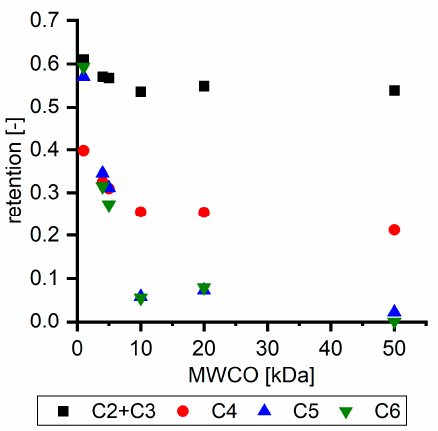
Figure 3. Retention of groups of hydroxy acids clustered based on their chain length.